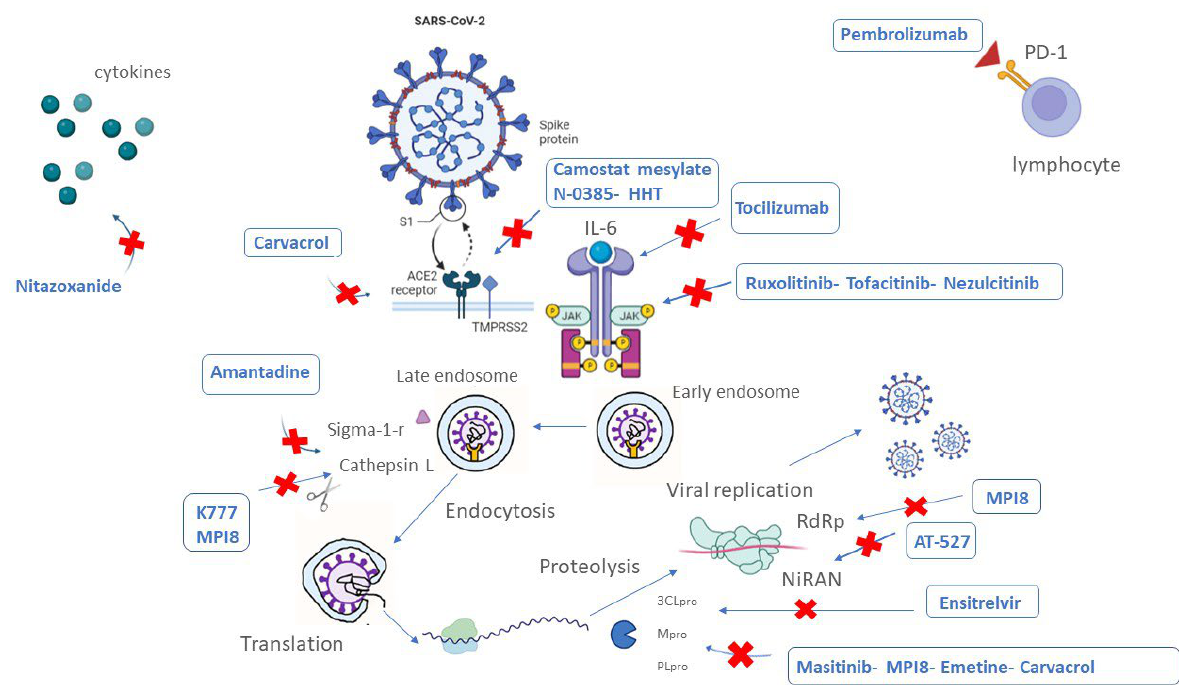
Figure 2. An illustrative picture showing the drugs/molecules in clinical and preclinical phase for COVID-19 therapy and their related targets.